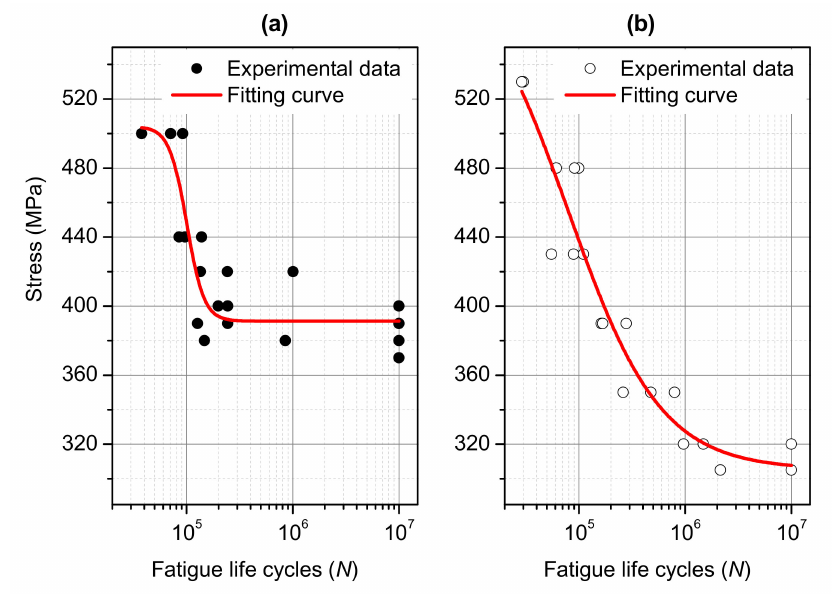
Figure 6. Stress-fatigue life ( S-N ) curves of Al-Si coated ( a ) and uncoated ( b ) specimens after hot stamping at 1193